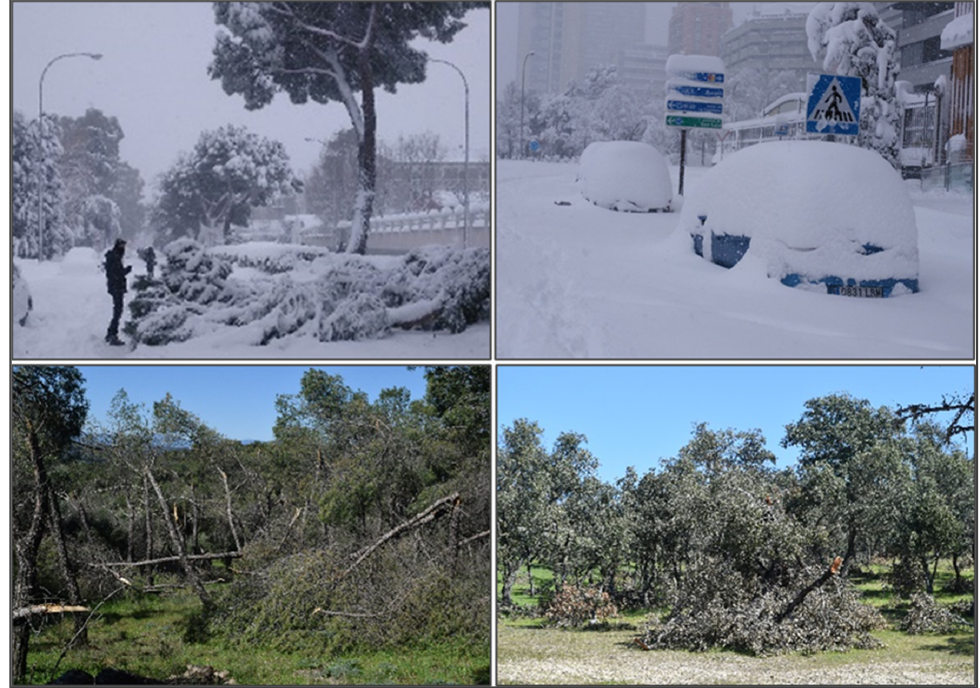
Figure 6. Snow accumulated by the Filomena Storm and impacts on trees: examples on urban roads and urban parks.